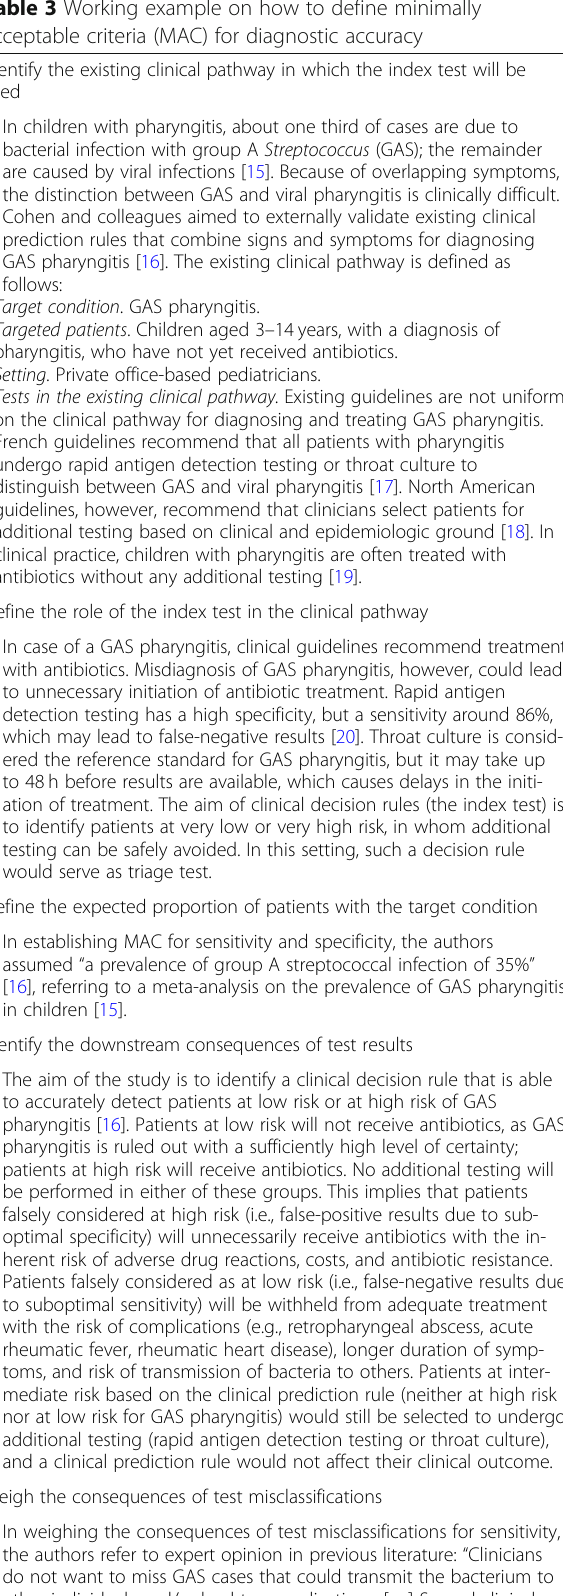
Table 3 Working example on how to define minimally